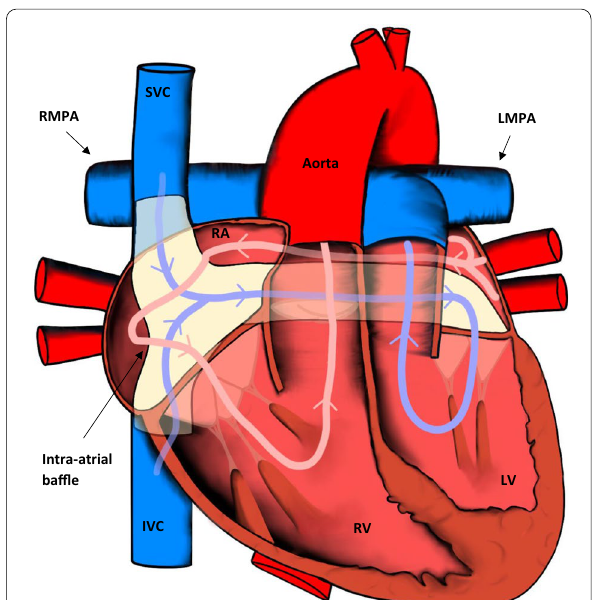
Fig. 2 Appearances of the heart after the atrial switch procedure. The SVC and IVC are baffled to the LV, whereas the pulmonary veins are baffled to the RV. IVC: inferior vena cava; LV: left ventricle; LMPA: left main pulmonary artery; RMPA: right main pulmonary artery; RA: right atrium; RV: right ventricle; SVC: superior vena cava